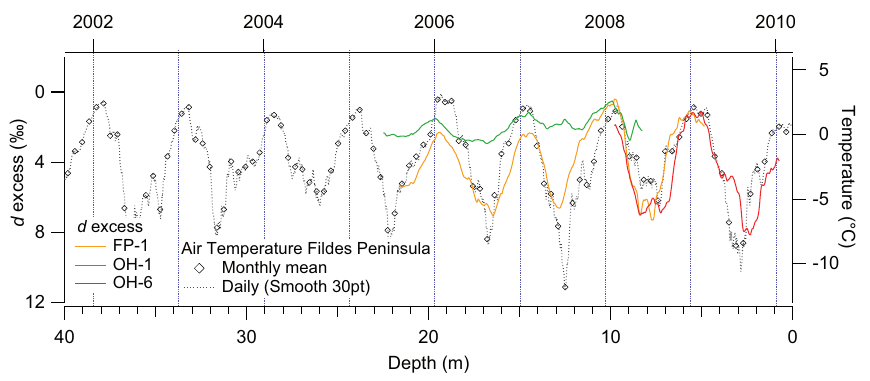
Fig. 13. Seasonality of d excess presented by three firn cores: FP-1 (King George Island), OH-1 and OH-6 (Antarctic Peninsula). The cores were retrieved in different field campaigns during 2008 and 2010, therefore the depth axis is only referential, note as well that the d excess axis has been inverted for better comparison of the data. Air temperature (dashed black line and diamonds) is from Bellingshausen Station, Fildes Peninsula (King George Island). The first day of the year is represented by the vertical